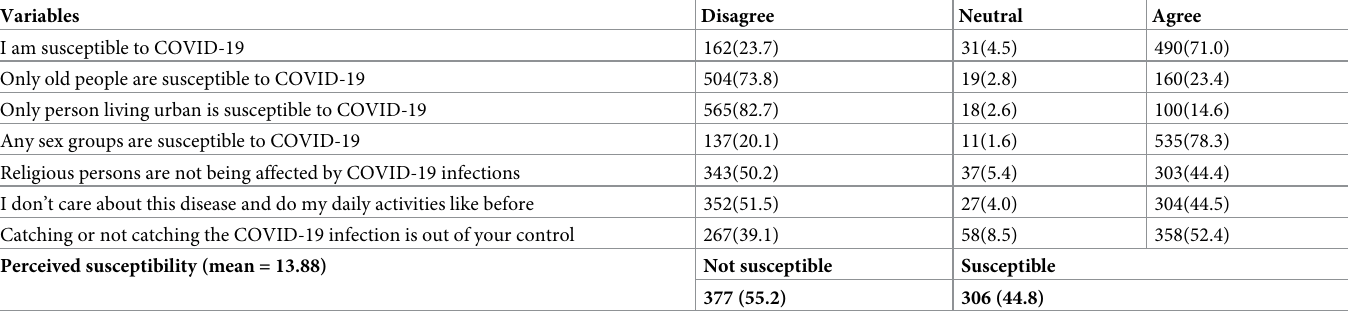
Table 3. The respondents’ perceived susceptibility to COVID-19 infection in North-shoa zone, Ethiopia.